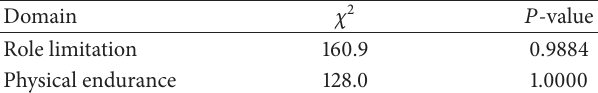
Table 7: Assessment of goodness-of-fit of Poisson